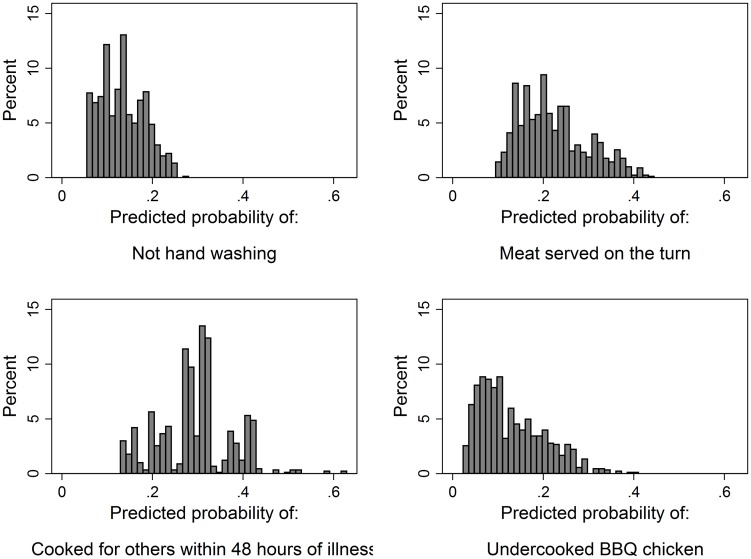
Distributions of members of the public’s (n = 926) simulated probabilities of committing the four studied food risk increasing behaviours.